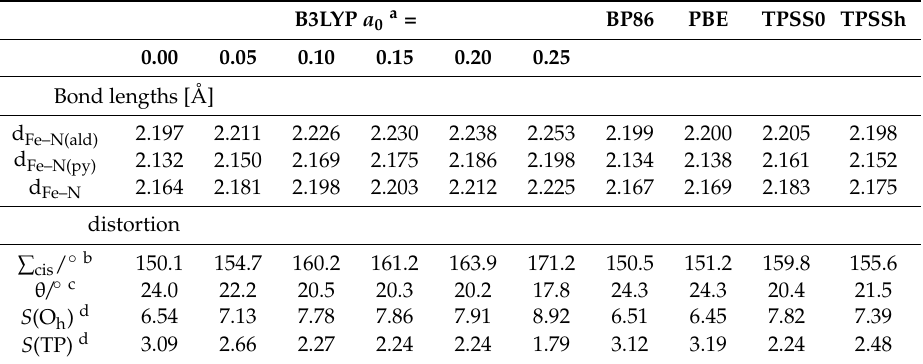
Table 3. Pertinent geometric parameters of DFT-optimized hs-[FeL] 2+ . B3LYP a 0 a = BP86 PBE TPSS0